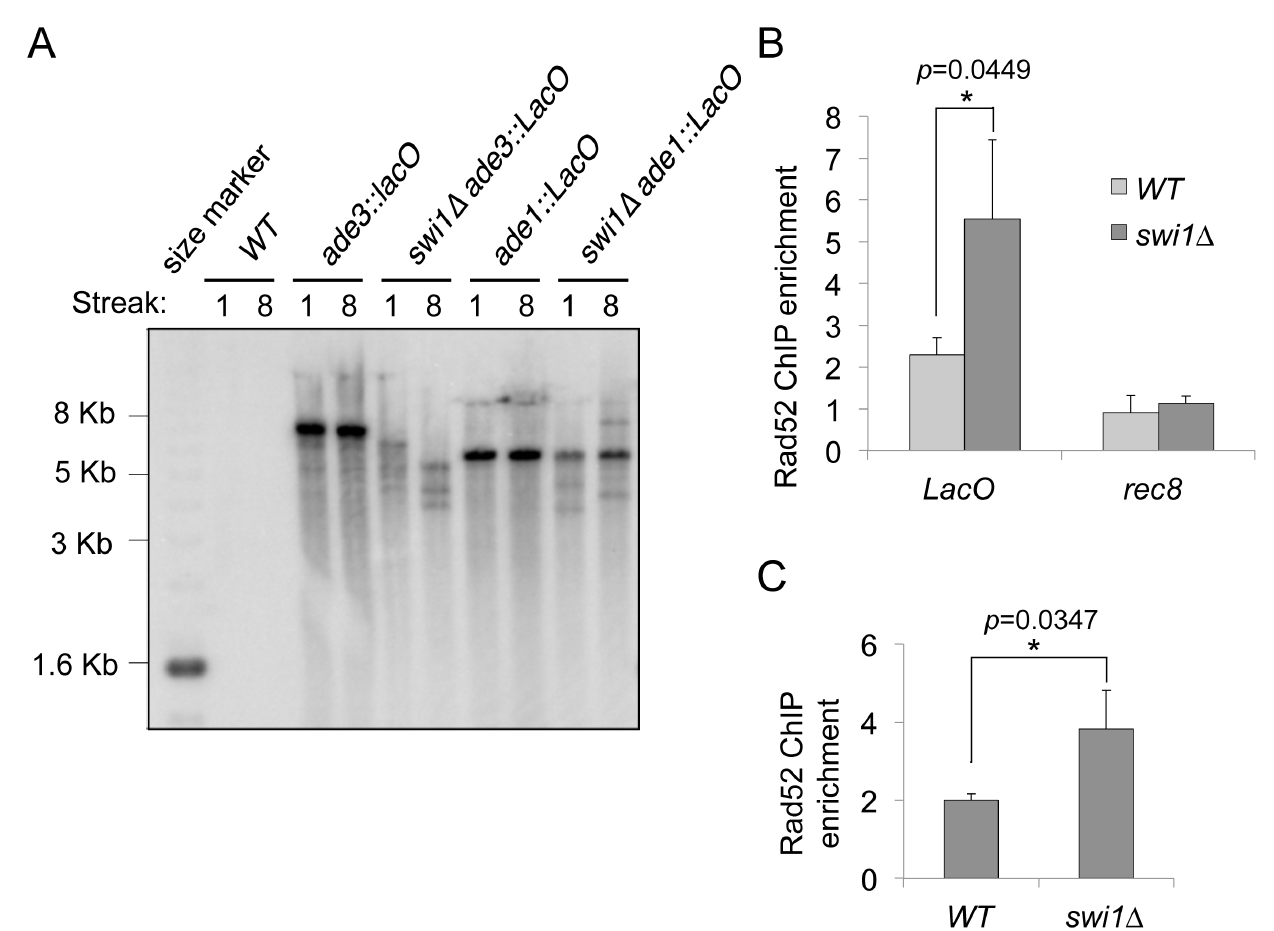
Fig 3. Swi1 is necessary for accurate replication of LacO -repeat DNA tracts. (A) Southern blot analysis using a LacO probe on genomic DNA extracted from wild-type or swi1 Δ cells carrying the LacO array. Genomic DNA was prepared after 1 or 8 restreaks after the indicated strains were generated, digested with StuI and separated on a 0.4% agarose gel. Similar results were obtained with another independent swi1 Δ ade1 :: LacO strain. A wild-type strain with no LacO repeats was used as a control for potential background hybridization. (B) Rad52 is enriched at LacO repeats but not at the meiotic gene rec8 where no replication obstacles are expected. ChIP assays of Rad52-12Pk were performed on cell extracts prepared form the indicated cells. The immunoprecipitated DNA was subjected to competitive multiplex PCR to monitor the association of Rad52-12Pk with the LacO tract and the rec8 gene, using the gene-free region 2 (GFR2) and GFR3 as internal amplification control loci, respectively. Chromatin association is presented as described in Fig 1C. Swi1 deletion significantly enhanced Rad52 recruitment at LacO repeats, while no significant difference was found at the rec8 locus. Statistical analysis of three independent experiments was performed as described in Fig 1C. (C) Swi1 deletion causes DNA damage at rDNA repeats. ChIP assays show enrichment of Rad52-12Pk at rDNA repeats in wild-type and swi1 Δ cells. swi1 Δ cells display a 2-fold increase in Rad52 binding at rDNA compared to wild-type. ChIP and competitive multiplex PCR were performed using primers specific for the rDNA (rDNA_2) and a gene-free region (GFR2). Statistical analysis of three independent experiments was performed as described in Fig 1C.